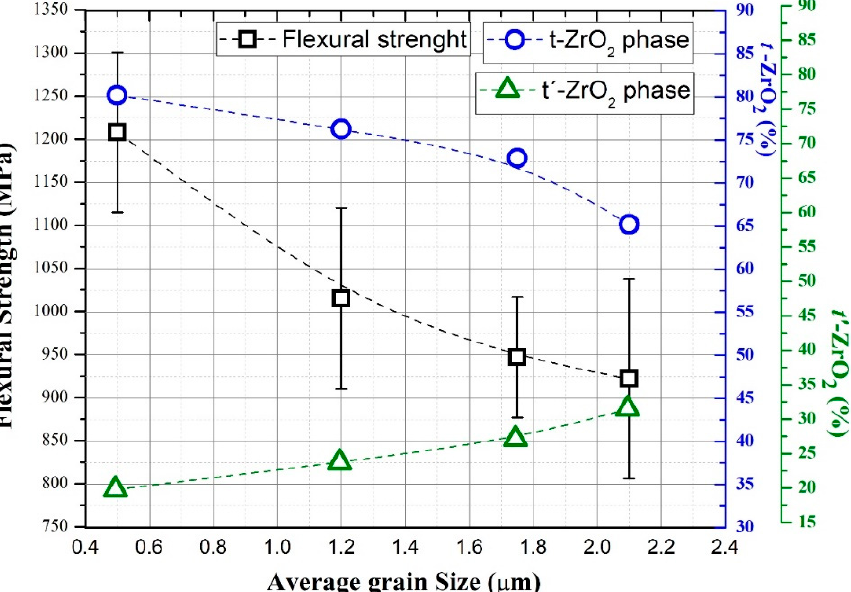
Figure 8. Correlation between average grain size and flexural strength associated with the phase contents of the material.